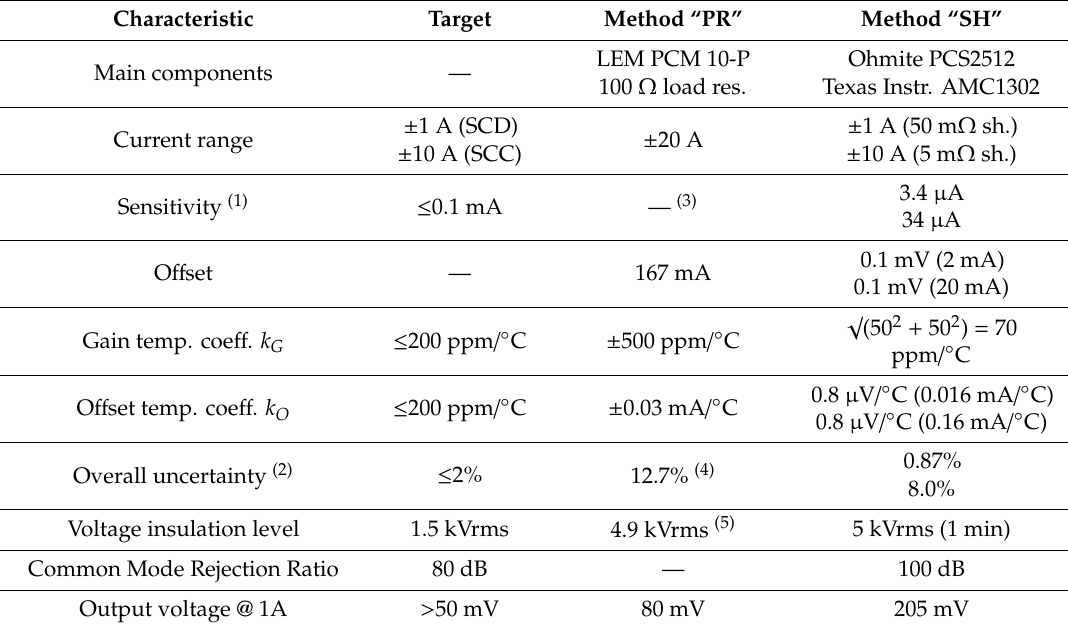
Table 1. Characteristics of two measuring systems for SCPS